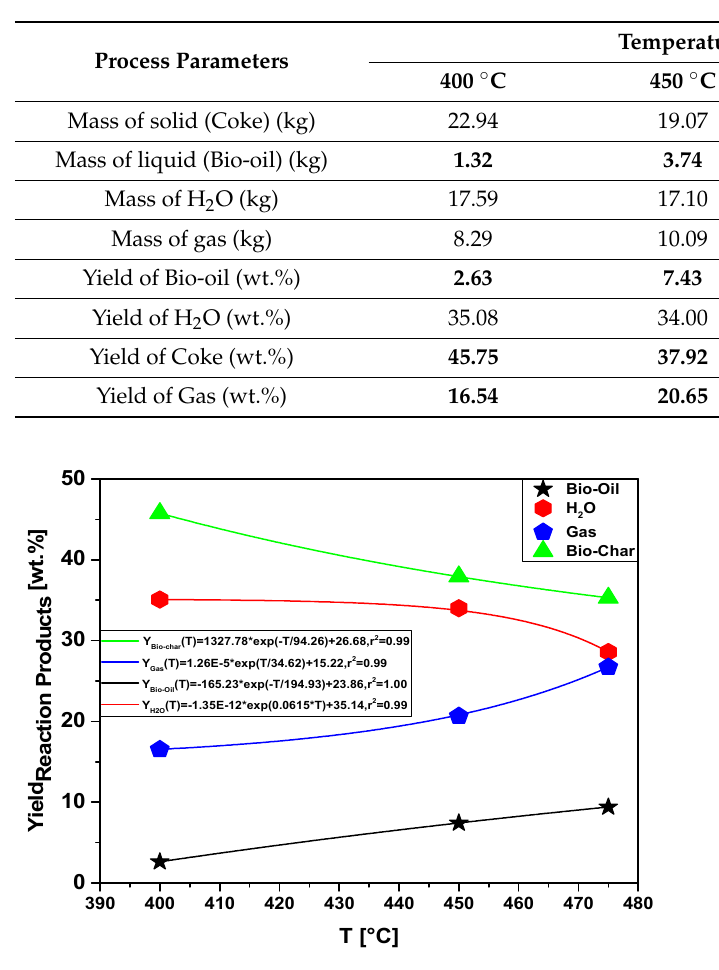
Figure 19. Effect of pyrolysis temperature on the yields of reaction products (bio-oil, aqueous phase, bio-char, and gas) by pyrolysis of MHSW fraction (organic matter + paper) at 400, 450, and 475 °C, 1.0 atmosphere, in laboratory scale.